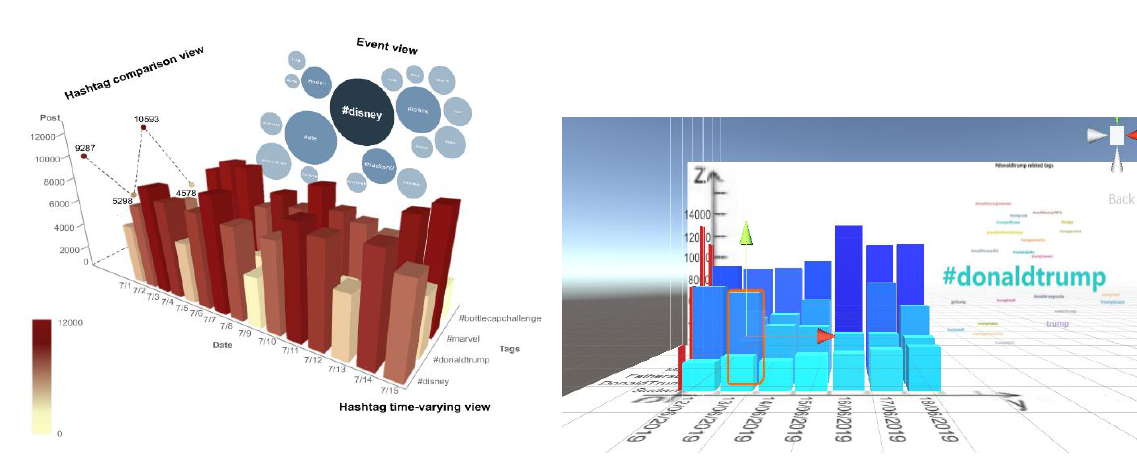
Figure 9 Final visualization model Figure 10 Visualization